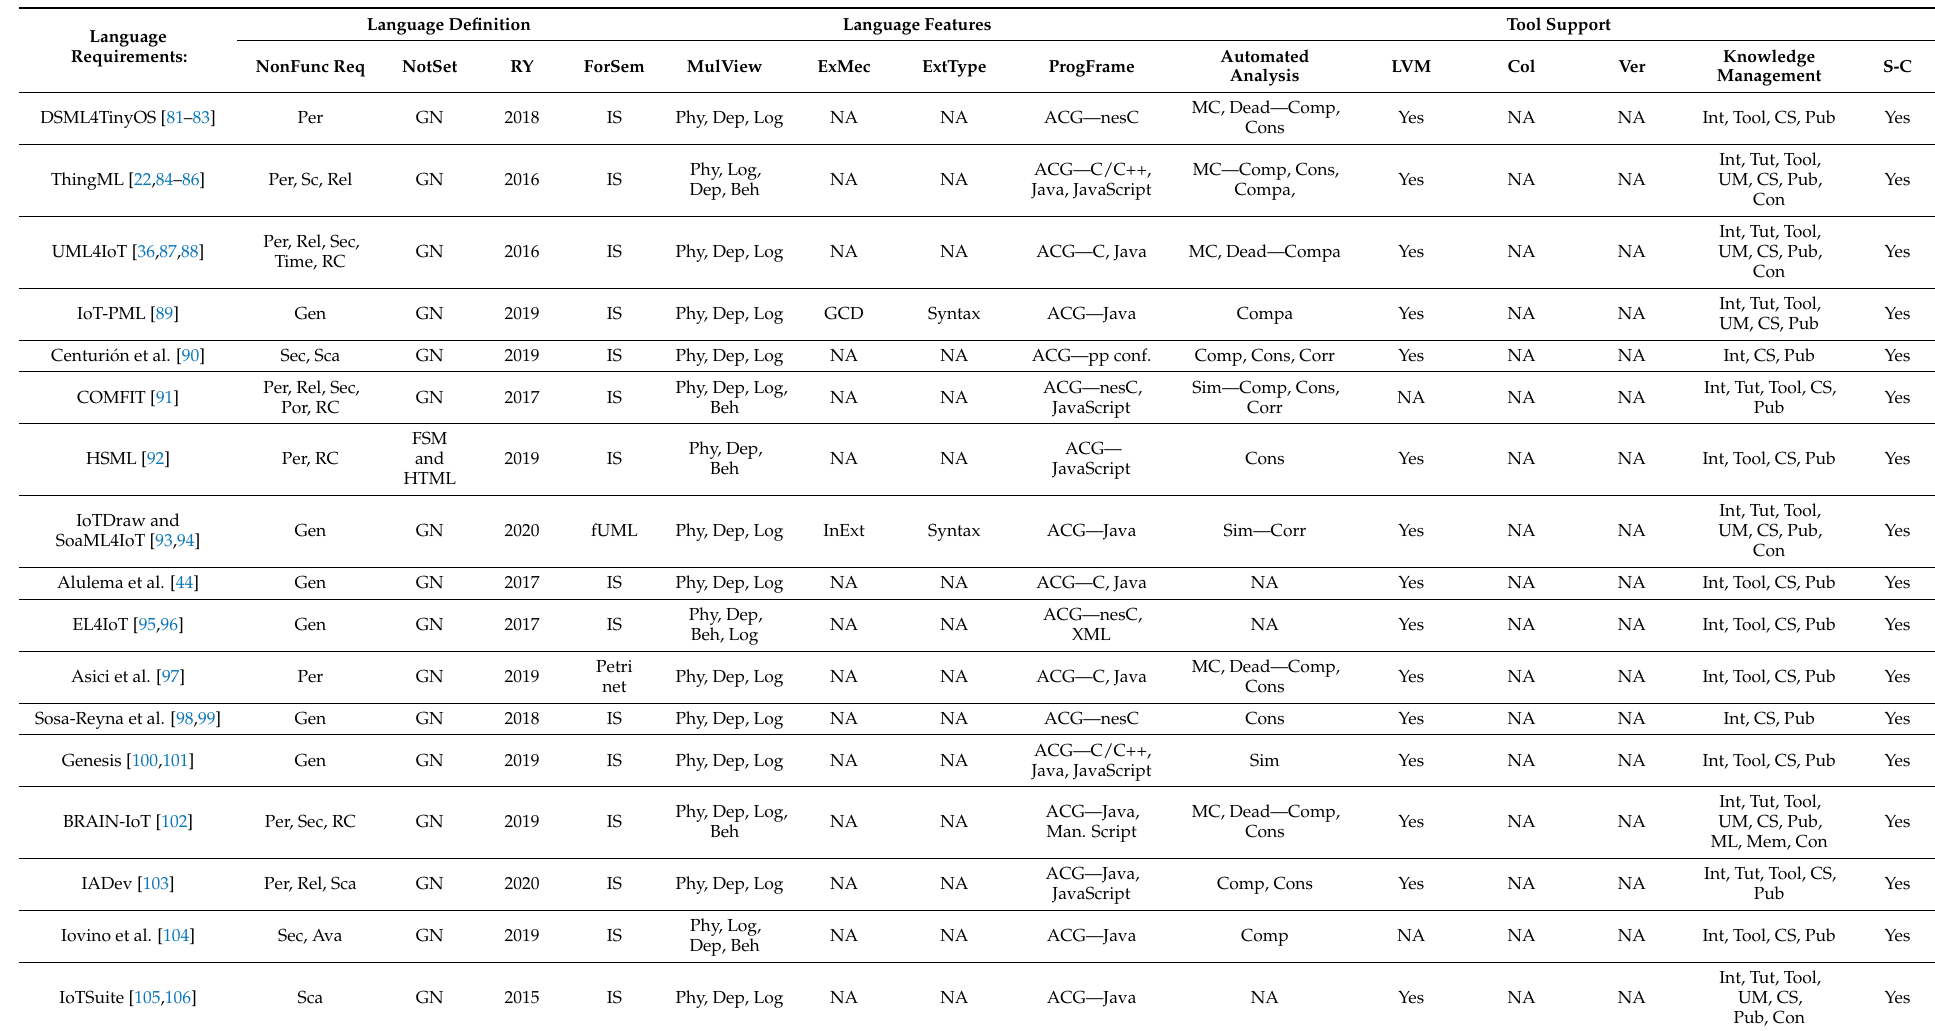
Table 12. The overall analysis results of the modeling languages for all the requirements